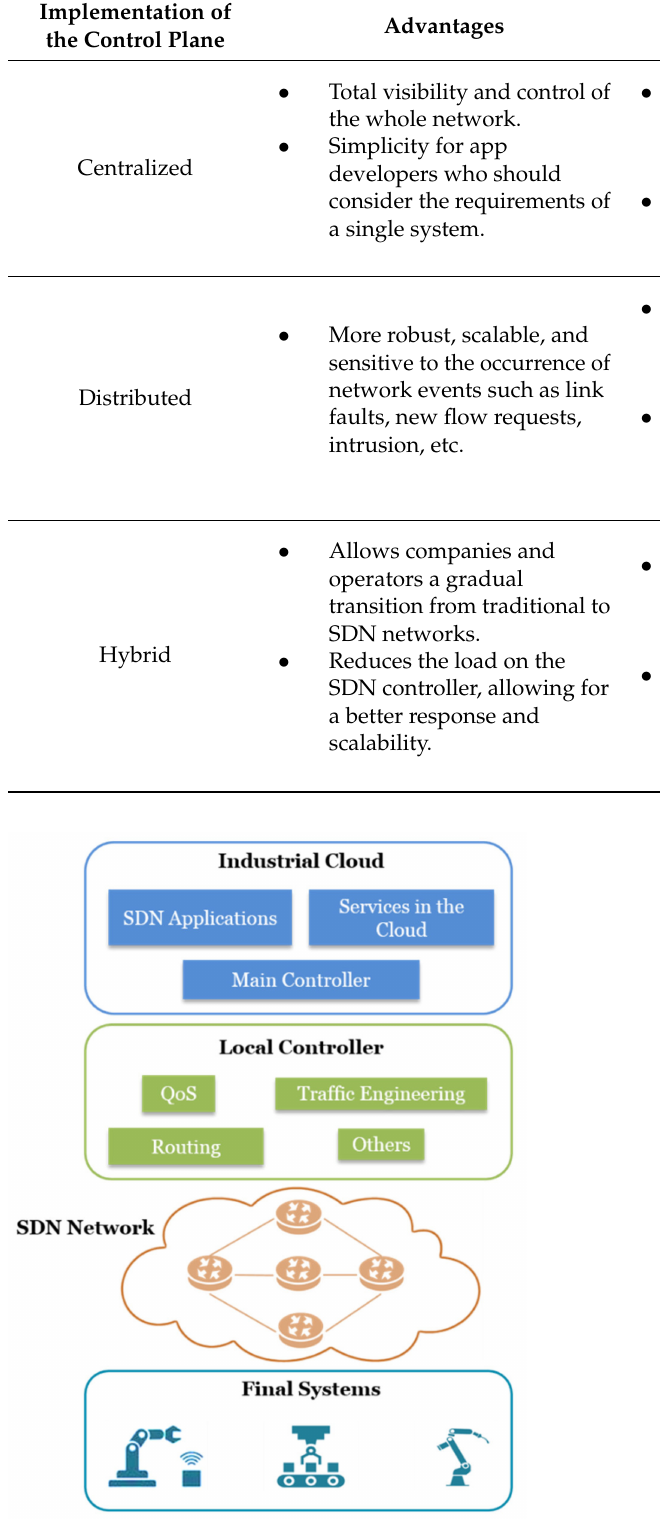
Figure 1. Decentralized architecture for SDN-IIoT